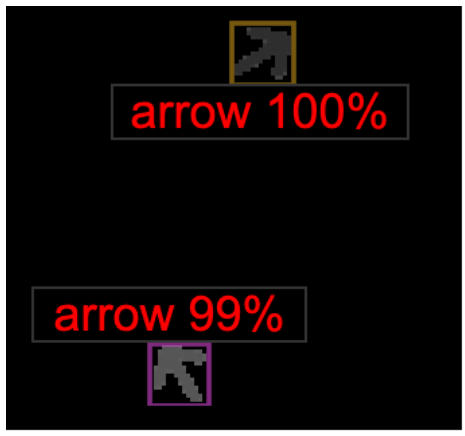
Figure 9. Arrow position detection for OSM.